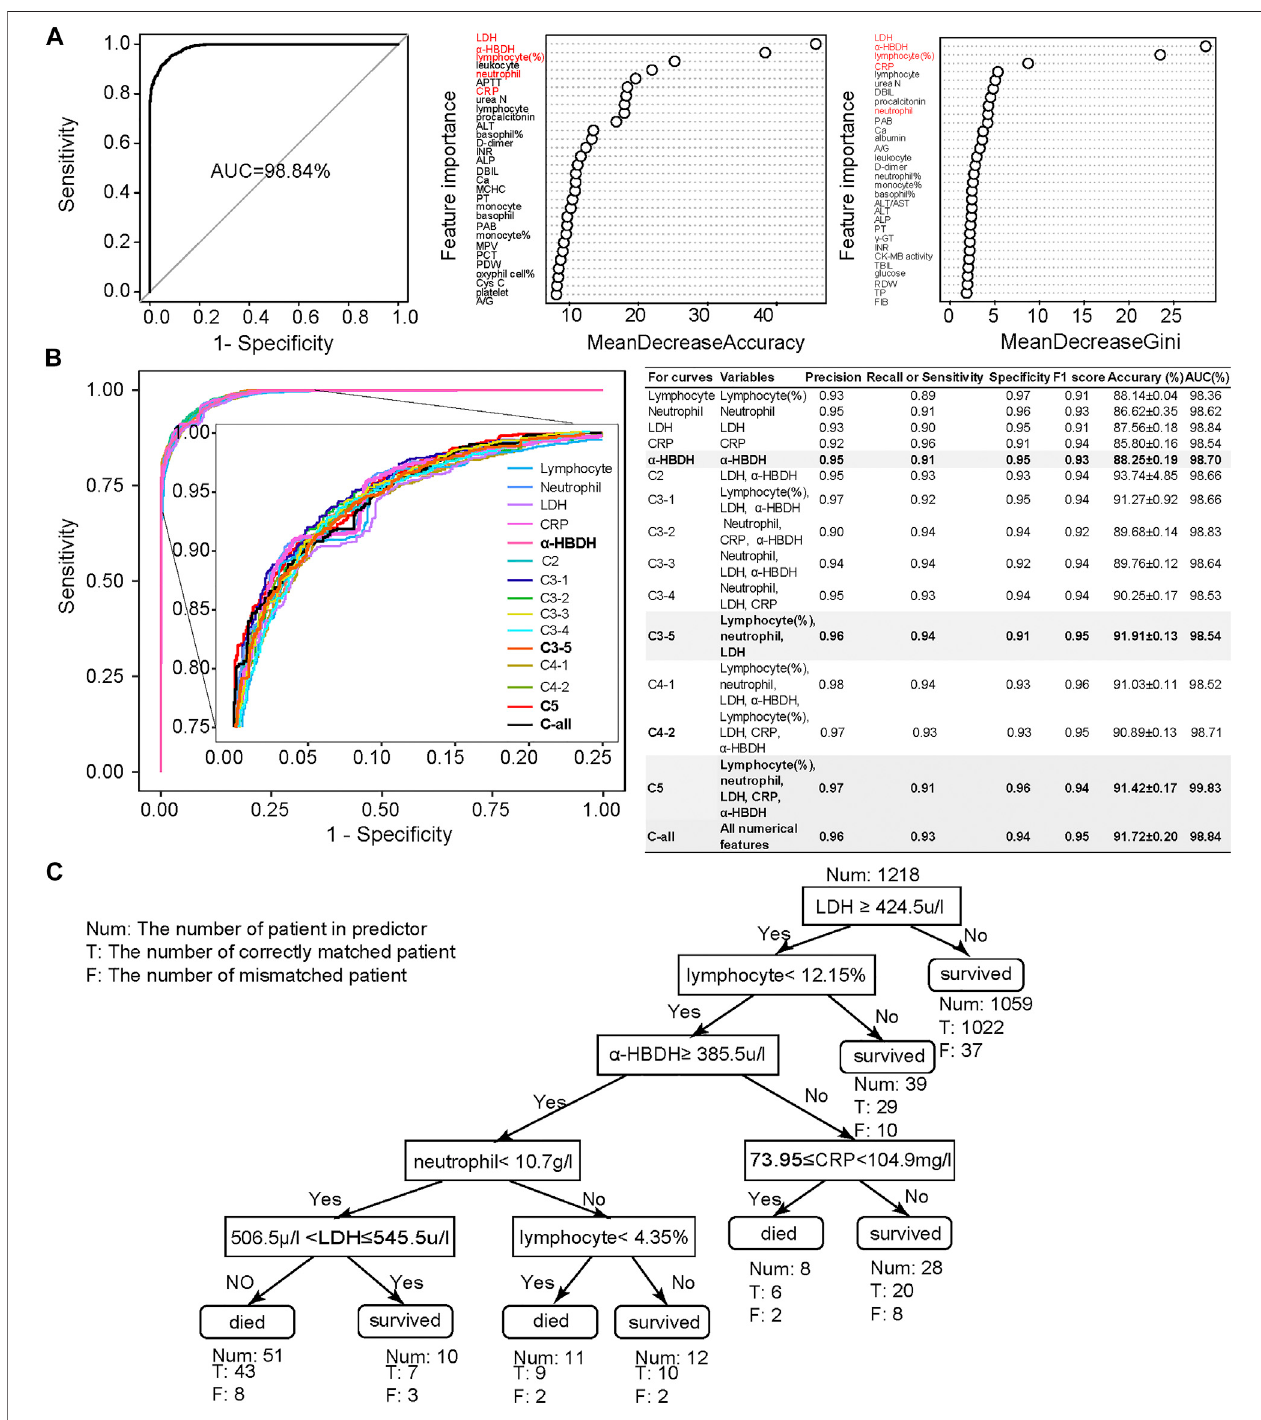
FIGURE 2 | Clinical feature selection and mortality prediction results utilizing the fi rst samples at admission. (A) Clinical feature selection based on 1,352 samples and 101 numerical features. Features were ranked by MeanDecreasedAccuracy and MeanDecreasedGini according to their importance. Considering both of these import RF parameters, we selected fi ve important clinical features: lymphocyte (%), neutrophil count, LDH, CRP, and α -HBDH. (B) Comparison of receiver operating characteristic(ROC)curvesanddiagnosticperformanceofallnumericalclinicalfeatures,subfeaturecombinations,aswellaseachselectedsinglefeature,usingthe fi rst samplesat admission (alsoreferred toasadmission-day 0). (C) The binary decisiontree forpredicting theoutcome ofCOVID-19 patientsbased onthe fi veselected clinicalfeaturesatadmission(admission-day0).Annotations:Num:thenumberofpatientsinthepredictor;T:thenumberofcorrectlymatchedpatients;F:thenumberof mismatched patients. Here, the Num above the root node indicates the total samples used for building the binary decision tree.